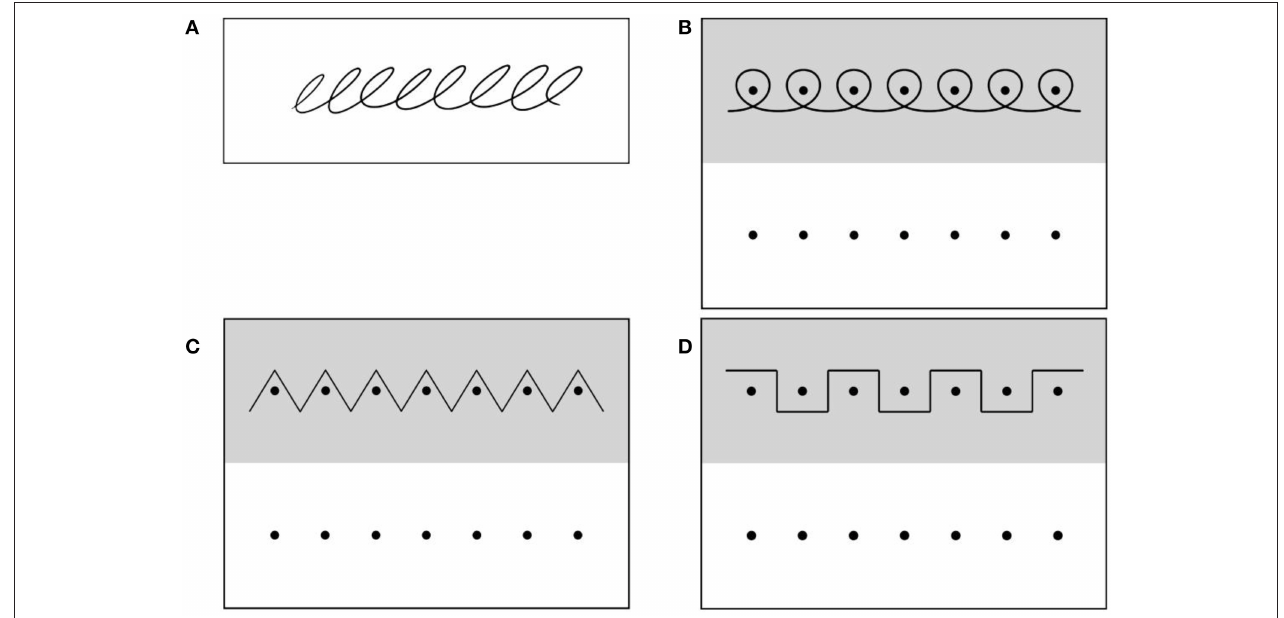
FIGURE 1 | Instruction (A): Copy the loop pattern on the next screen. (B–D) Copy the pattern above in the space below. Reprinted from Gerth et al. (2016) with permission from Elsevier.